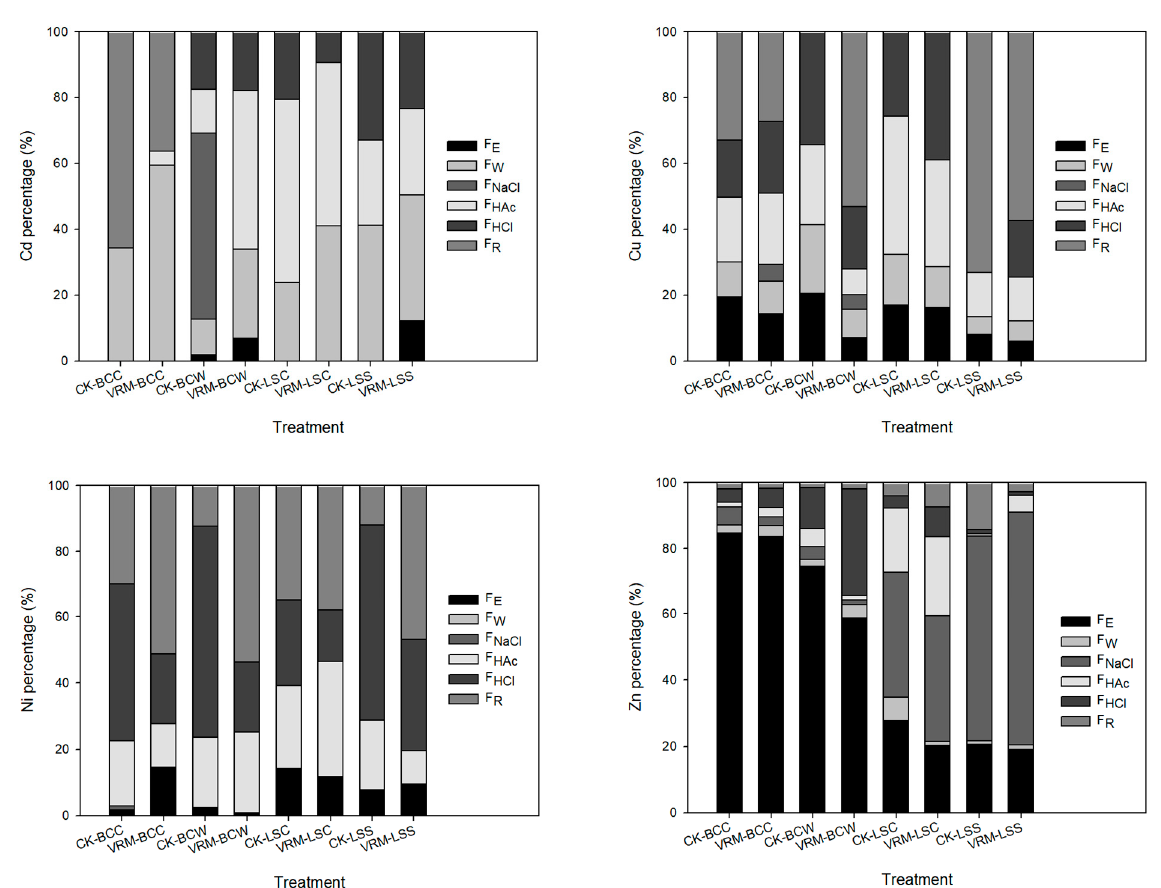
Figure 4. Effects of different treatments on the chemical forms of Cd, Cu, Ni, and Zn in the blanched shoots of pak choi and lettuce. The meaning of each code is the same as in Table 1.